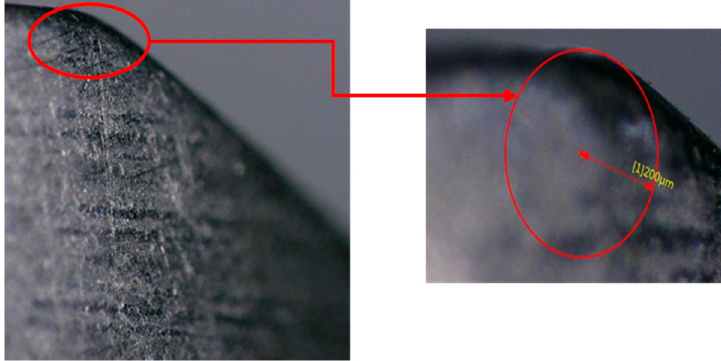
Figure 13. Radius of curvature of the 0.3 cal. FSP.